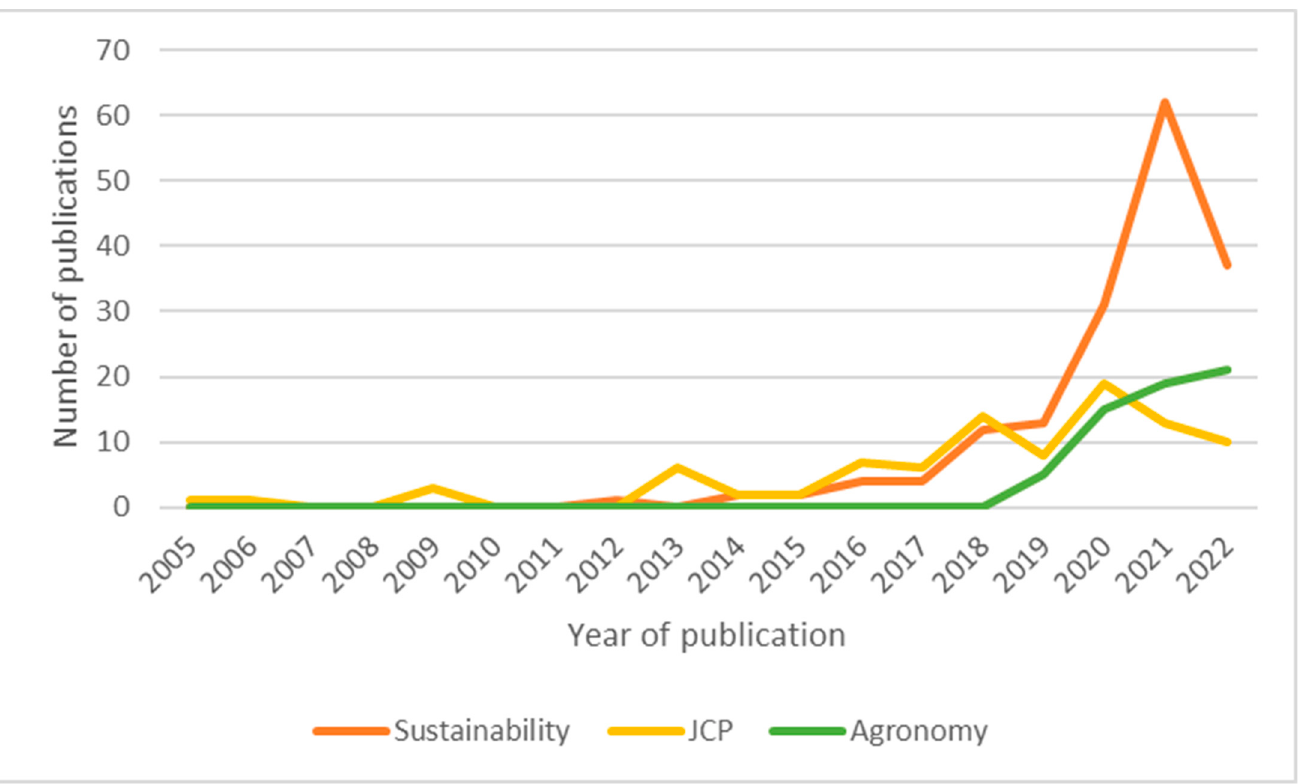
Figure 4. Evolution of the number of articles published by the three leading journals identi fi ed.